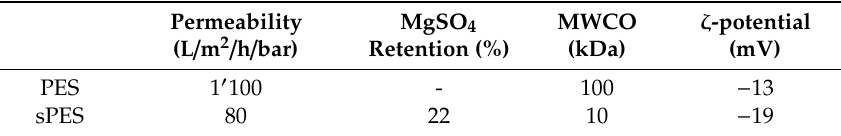
Table 1. Properties of virgin membranes